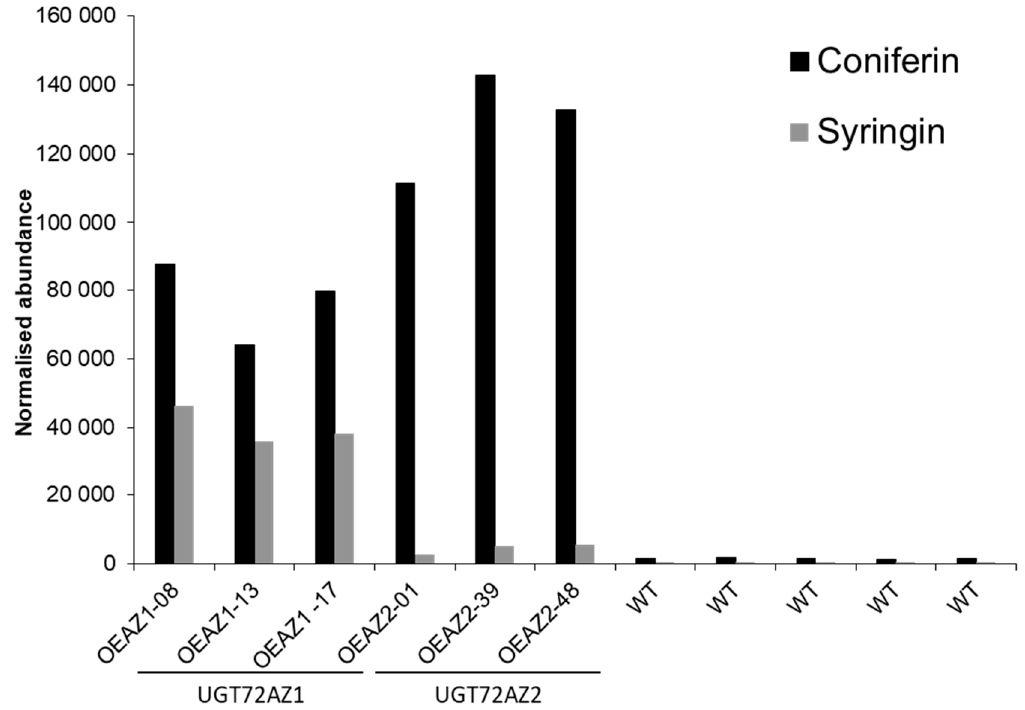
Figure 4. LC-MS analysis of coniferin and syringin in leaf of 4-month-old wild type (WT), UGT72AZ1 , and UGT72AZ2 overexpressing lines grown in the greenhouse. Measures were made in 5 independent WT and in 3 independent transgenic lines for each construct. This analysis was repeated with HPLC-UV with similar results.